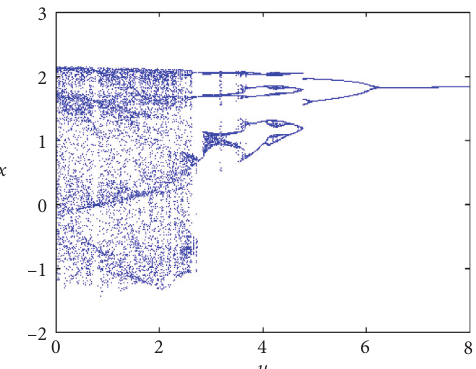
Figure 8: Bifurcation diagram with respect to the initial conditions u (0) in region of [0, 8].